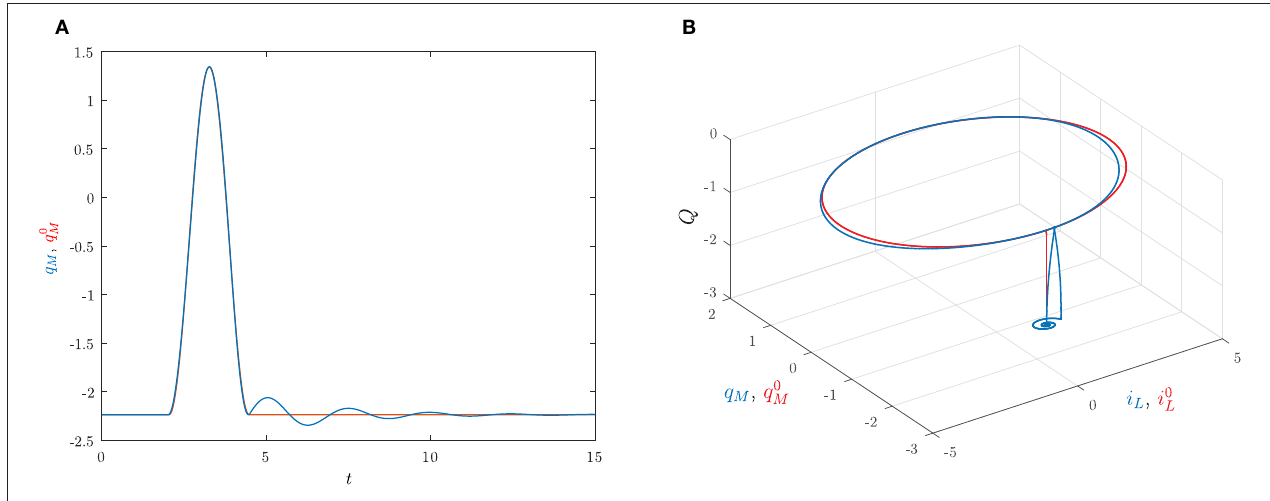
T 1 4.4821 with area 3 + + =